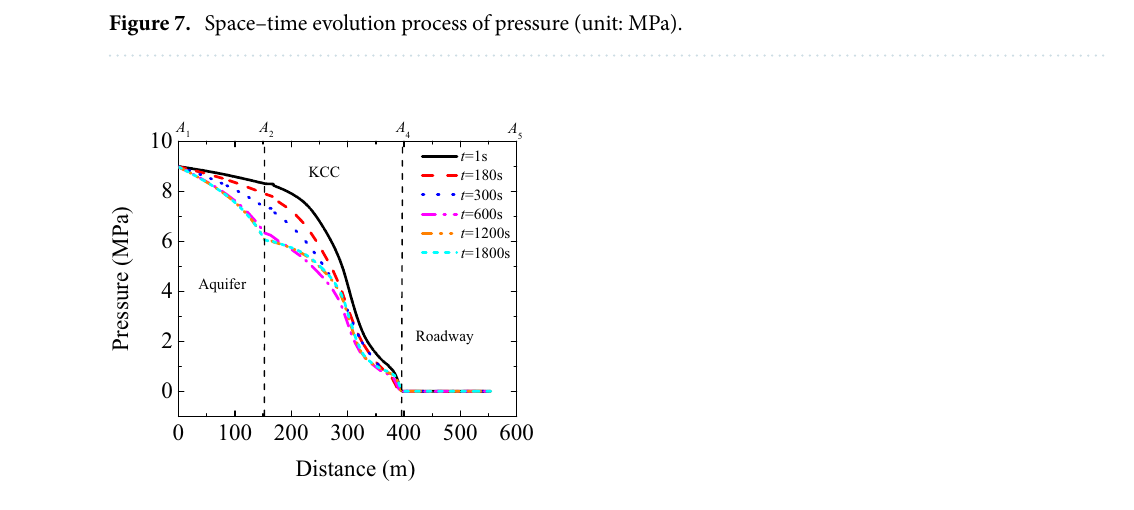
Figure 8. Curve of water pressure from Ordovician limestone aquifer to tunnel ( A 1 - A 2 - A 4- A 5